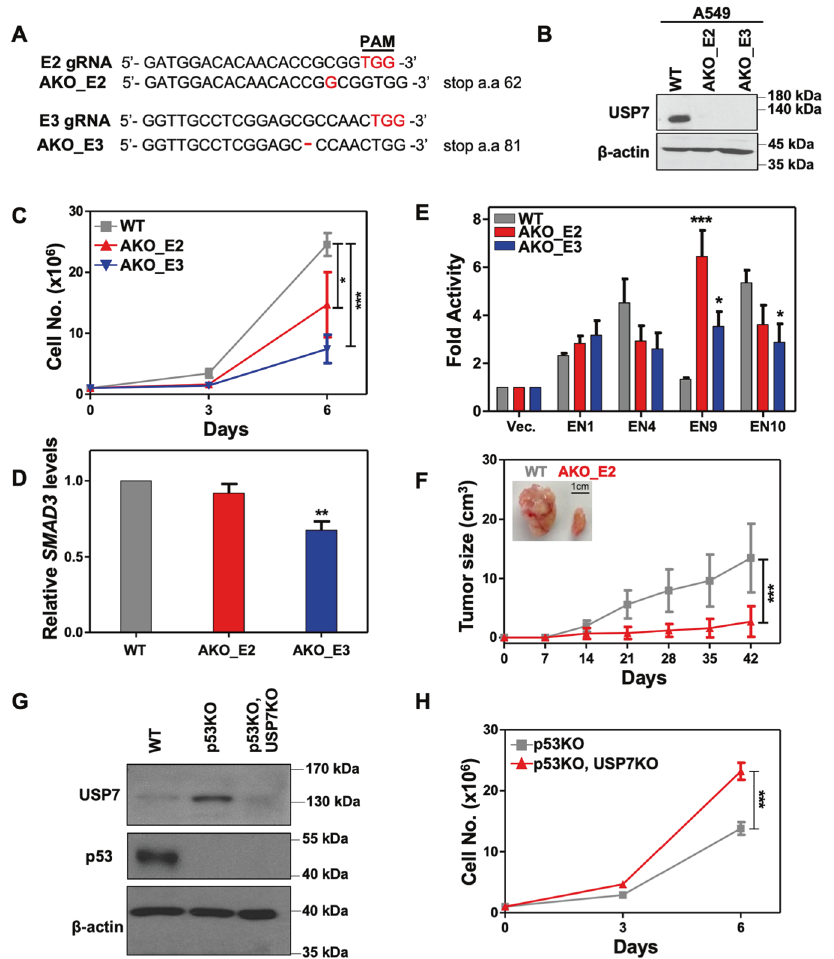
Fig. 7 Inactivation of USP7 decreases cell progression of p53-positive lung cancer A549 cell line. A Schematic of guide RNA (gRNA) design and genomic sequences of USP7 knockout (KO) A549 clones. AKO_E2 Exon 2 targeted; AKO_E3 Exon 3 targeted. B Immunoblots of USP7 in the lysates of wildtype or USP7 KO A549 cells. β -actin is the loading control. C Cell proliferation assays showing the growth of wildtype (WT) and USP7 KO A549 (AKO_E2 and AKO_E3) cell lines. Data were means ± SD from three independent experiments. D RT-qPCR assays showing the SMAD3 mRNA levels in wildtype (WT) or USP7 KO A547 cell lines. E Luciferase reporter assays showing the relative enhancer activities of indicated SMAD3 SE constituents in wildtype (WT) and USP7 KO A549 cells. The normalized luciferase activity of pGL3-promoter was set to 1. F The growth curves of xenografted tumors with wildtype (WT) or USP7 KO (AKO_E2) A549 cell lines. The tumor sizes were determined every 7 days using an external caliber. The data were presented as means ± SD from a cohort of six mice. The inset showing the representative images of tumors on day 42. Student ’ s t -test, * p < 0.05; ** p < 0.01; *** p < 0.001. G Immunoblots of USP7 and p53 in the lysates of wildtype (WT), p53 KO, and p53 and USP7 double KO A549 cells. β -actin as an internal control. H Cell proliferation assays showing the growth of p53 KO or p53 and USP7 double KO cell lines. Data were means ± SD from three independent experiments. Student ’ s t -test, *** p <